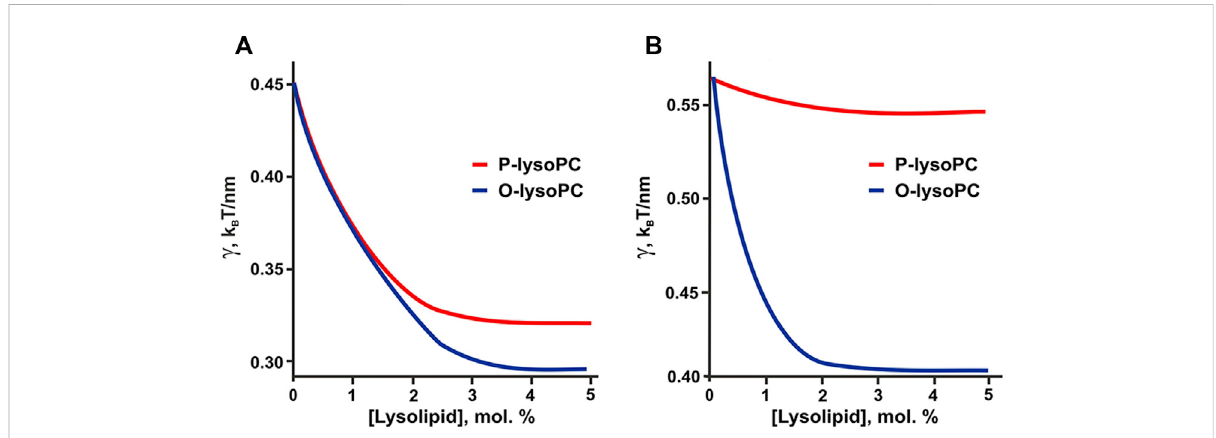
FIGURE 6 Calculated dependence of the line tension of the raft boundary on the total lysolipid content in the eSM:DOPC:Chol membrane. (A) eSM/ DOPC/Chol = 1:1:1. (B) eSM/DOPC/Chol = 2:2:1.